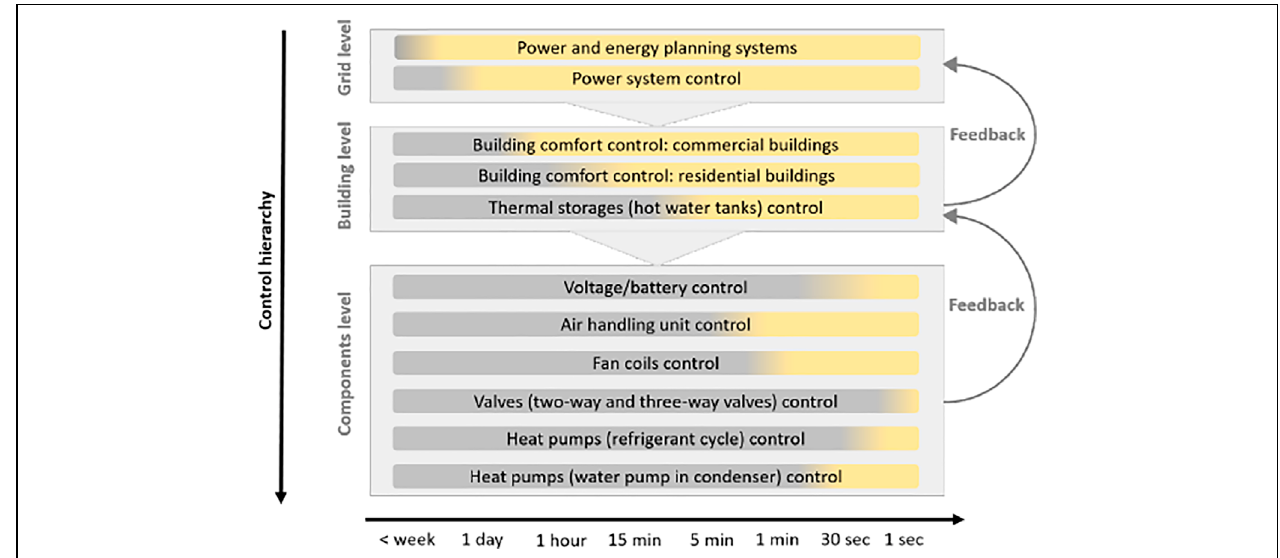
FIGURE 1 | Control hierarchy and levels of integration: the yellow(light) zone shows the part where the system behaves dynamically.